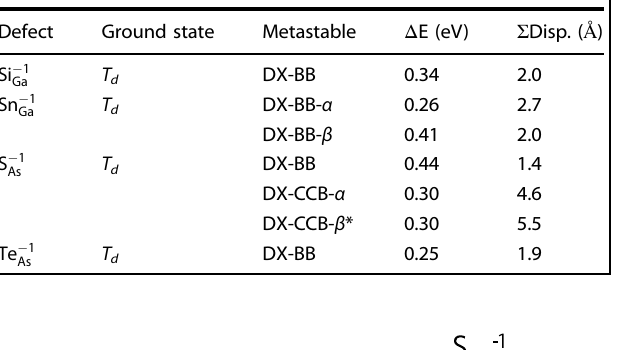
Table 5. Energy difference and summed atomic displacements ( Σ Disp.) between the identi fi ed metastable con fi gurations and the ground state T d for the DX centres in GaAs. For S (cid:2) 1 con fi guration not found by our method (DX-CCB- β *) but reported in a previous study 22